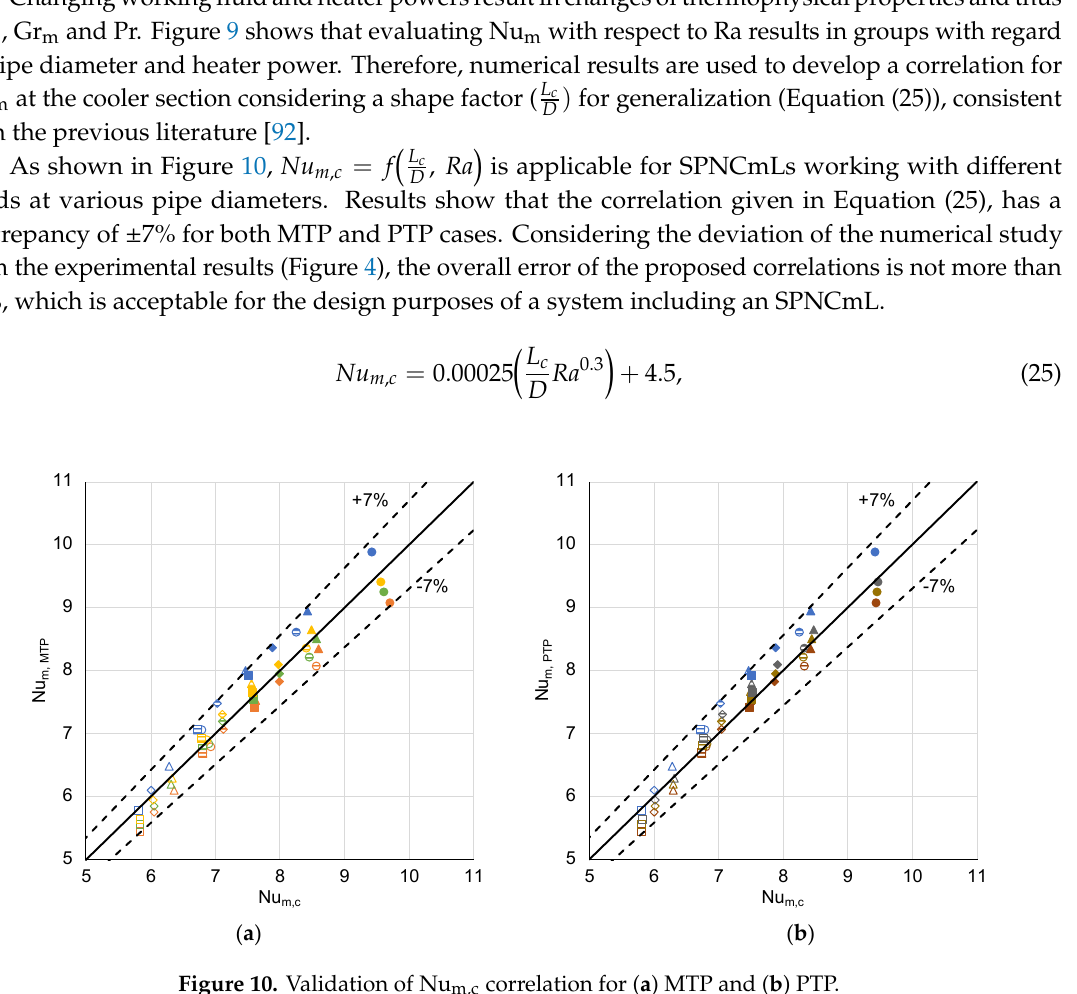
Figure 9. Change of Nu m with Ra for ( a ) MTP and ( b ) PTP.